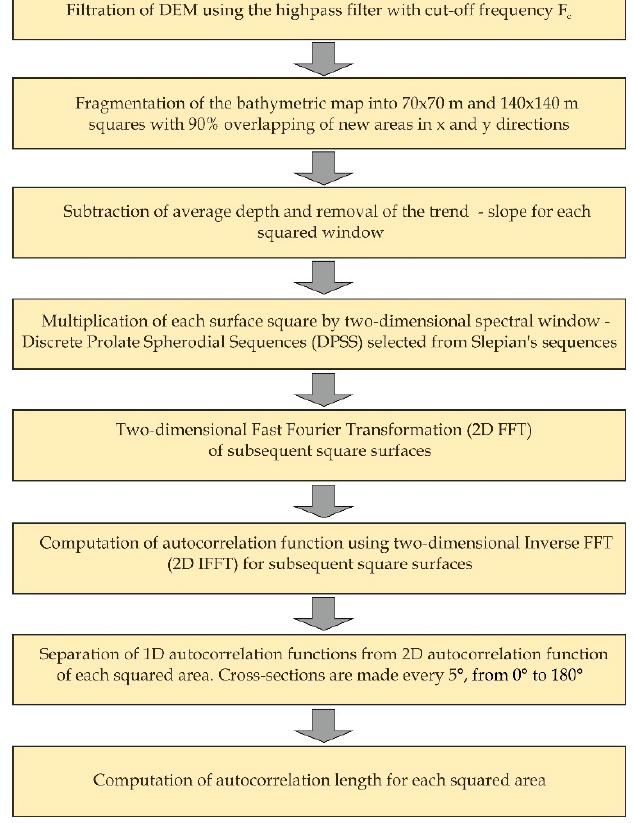
Figure 4. Flowchart of the autocorrelation length computation.